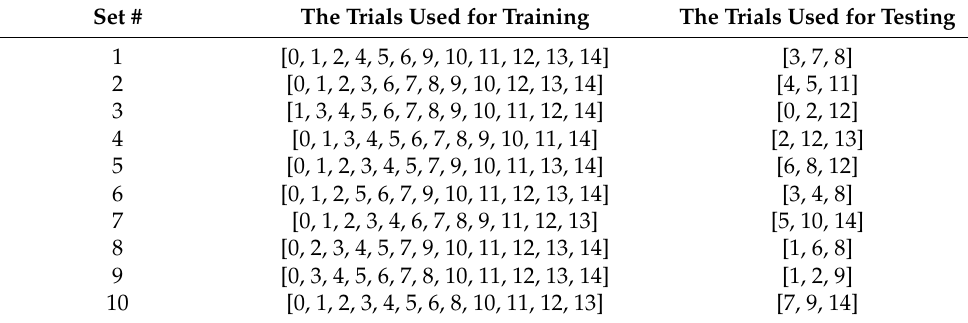
Table 4. Details of the 10 sets used for training and testing. Please note that the 15 trials are numbered from 0–14.